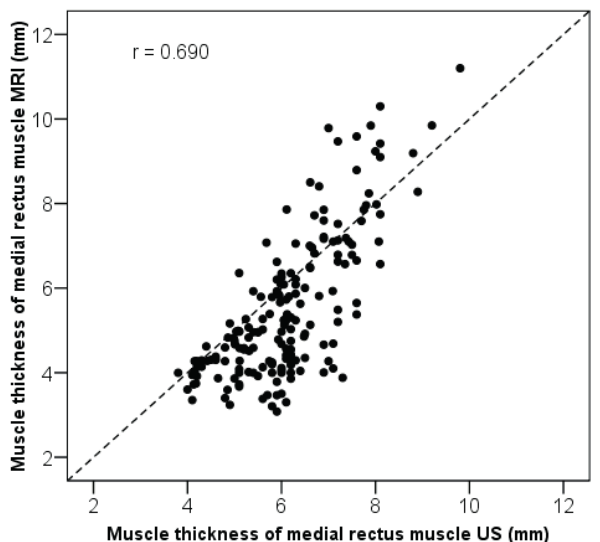
Fig. 1. Spearman correlation between ultrasound (US) and MRI for the medial rectus muscle (r = correlation coefficient).